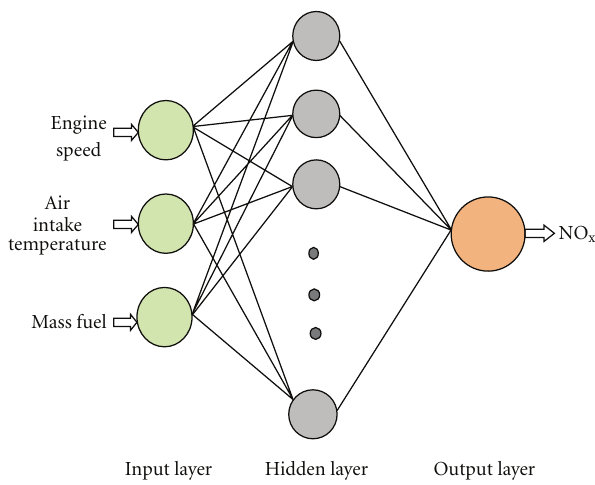
Figure 2: Simple structure of used